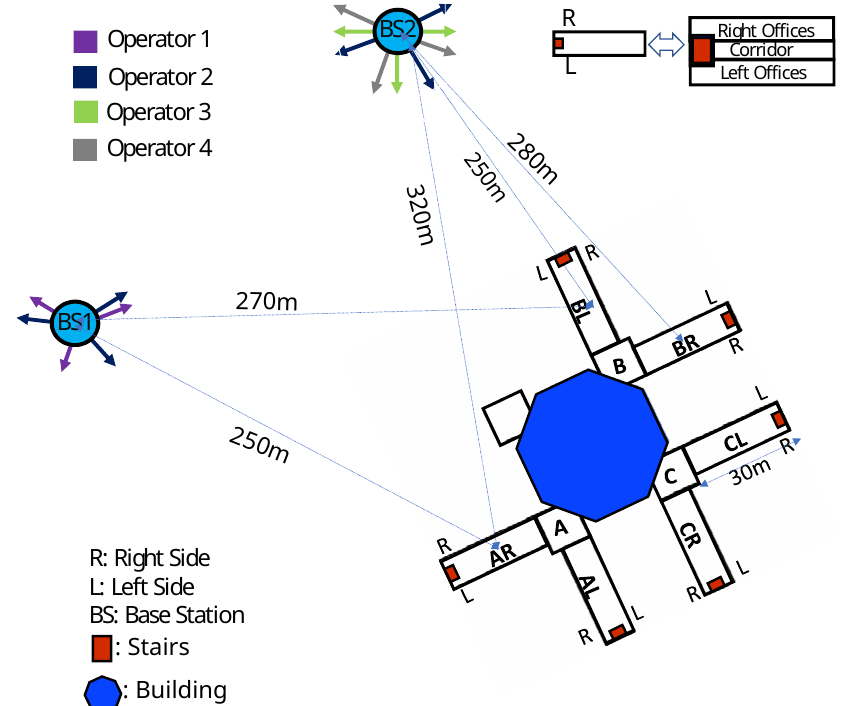
Figure 3. Building plans with respect to the base